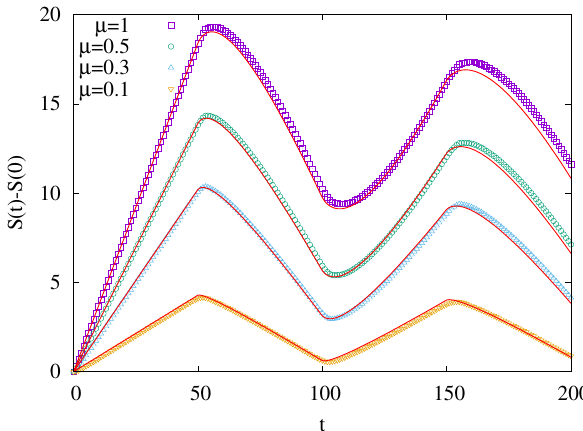
Figure 9: Entanglement decay and revival in the homogeneous quench for various µ and L = 50. The red solid lines show the quasiparticle ansatz